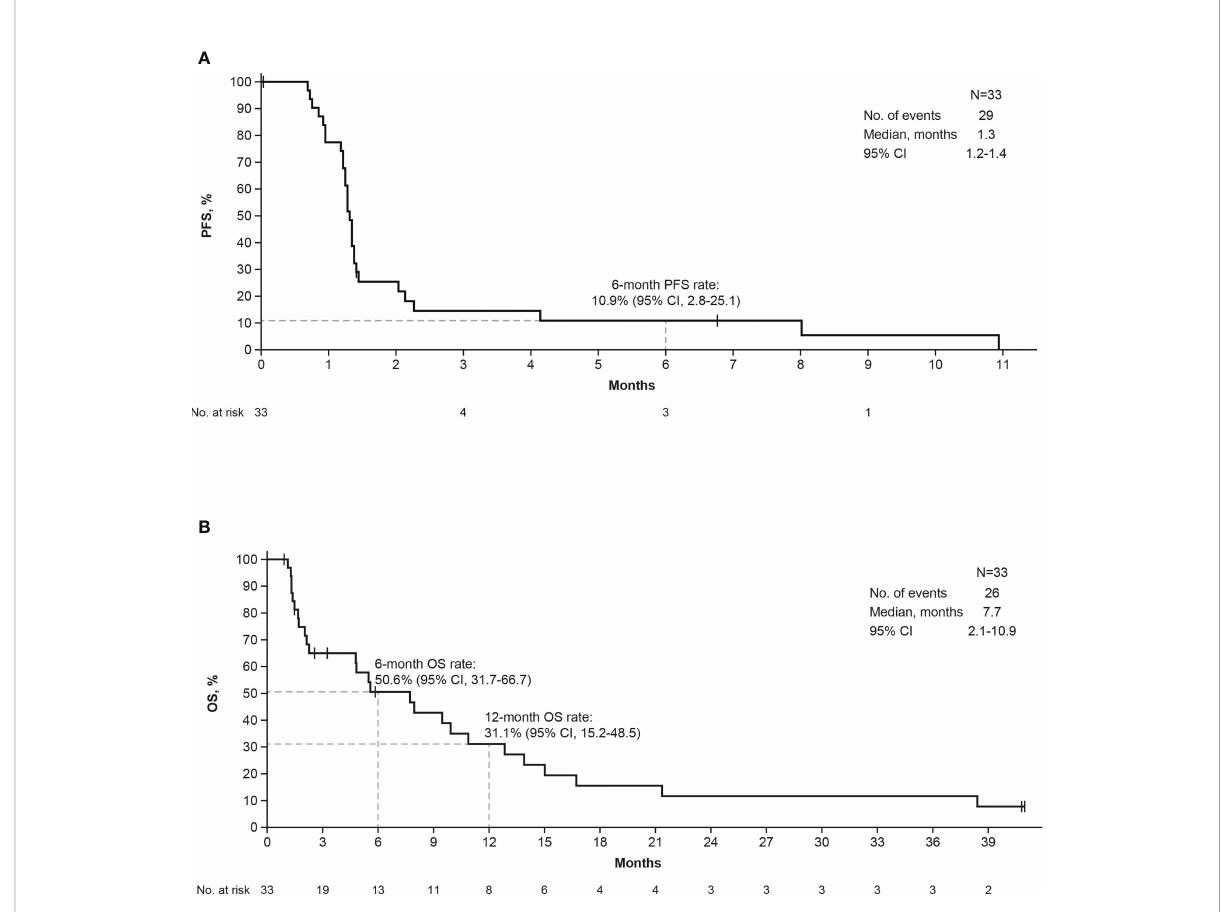
FIGURE 1 Kaplan-Meier curves of IRC-assessed PFS (A) and OS (B) . IRC, independent review committee; OS, overall survival; PFS, progression-free